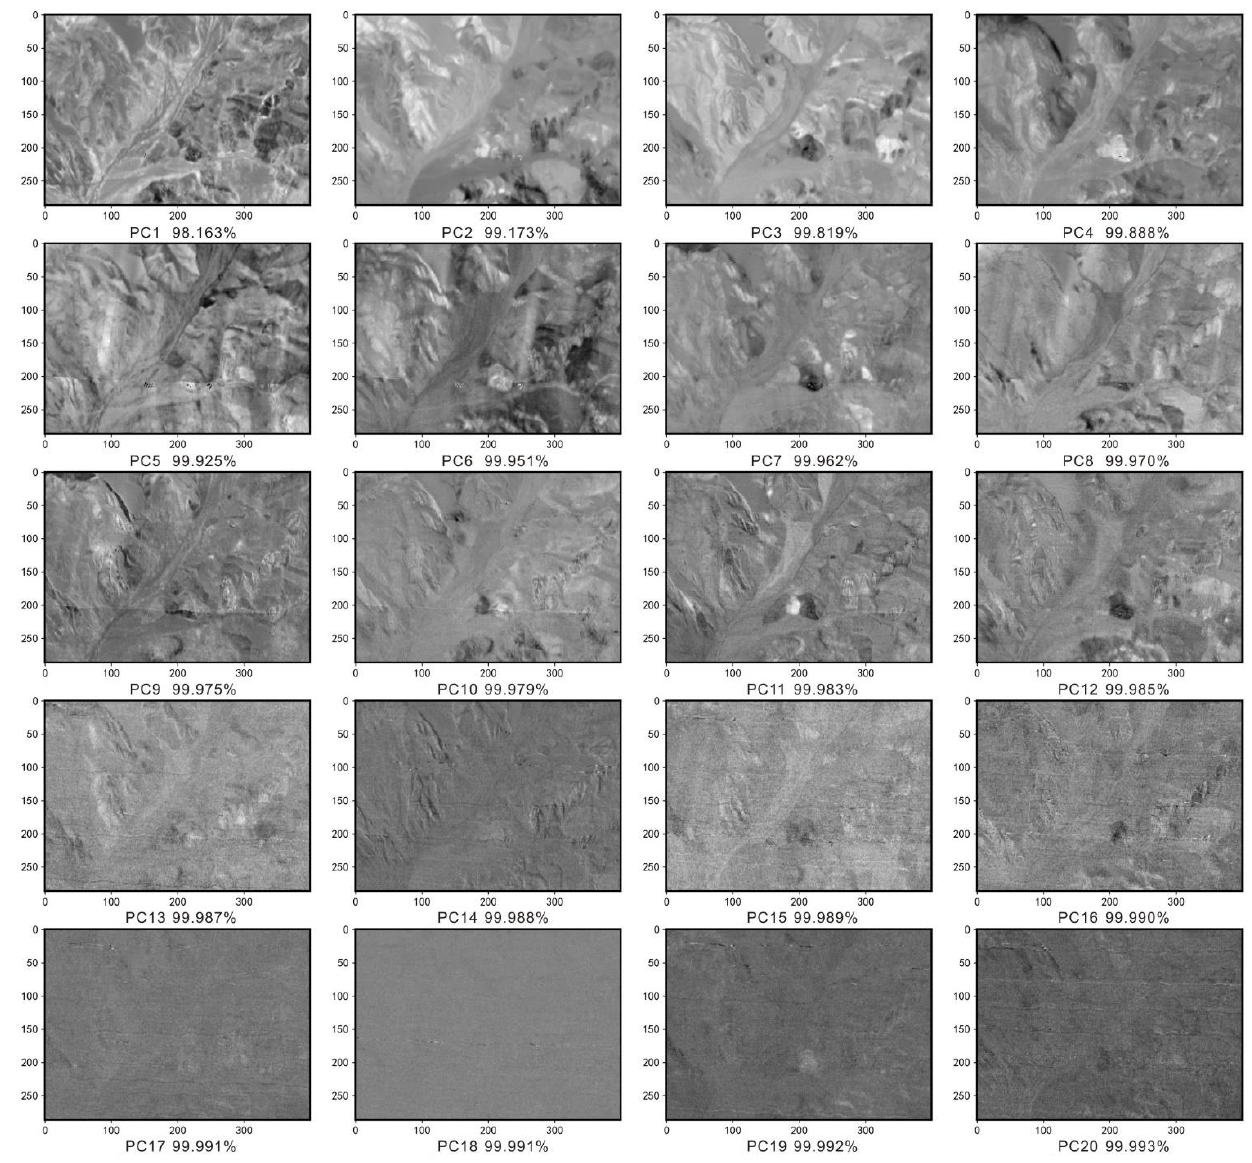
Figure 9. The first 20 principal component images after PCA of the SASI image, the total information content contained in the corresponding principal component and all upper principal components, and the horizontal and vertical axes of the image represent the number of image pixels.